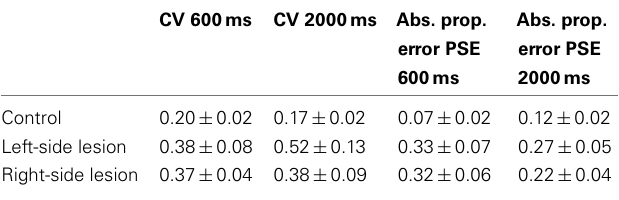
Table 3 | Performance of controls versus left- and right-sided lesion patients.